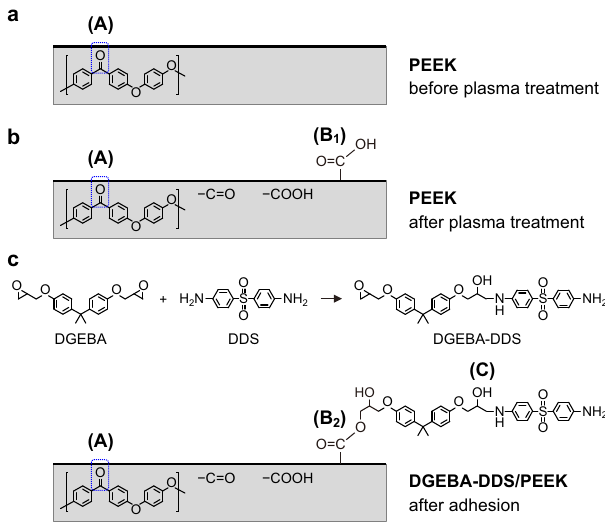
Fig. 5 Schematics of the adhesion mechanism of DGEBA-DDS on plasma- treated PEEK. a Untreated PEEK sample. The C = O group in PEEK appeared as feature A in XAS. b Plasma-treated PEEK sample. Plasma-induced oxygen radicals introduced the bond scission of PEEK and the formation of a COOH group, which appeared as feature B 1 in XAS. c The DGEBA-DDS/ PEEK interface. The curing reaction of the DGEBA monomer with the DDS curing agent is also shown. The epoxy group in DGEBA is covalently bonded with the amino group in DDS to form a cross-linking structure of DGEBA-DDS. The unreacted epoxy group in the DGEBA unit forms an ester bond with the plasma-induced COOH group on the PEEK surface, which appeared as feature B 2 in